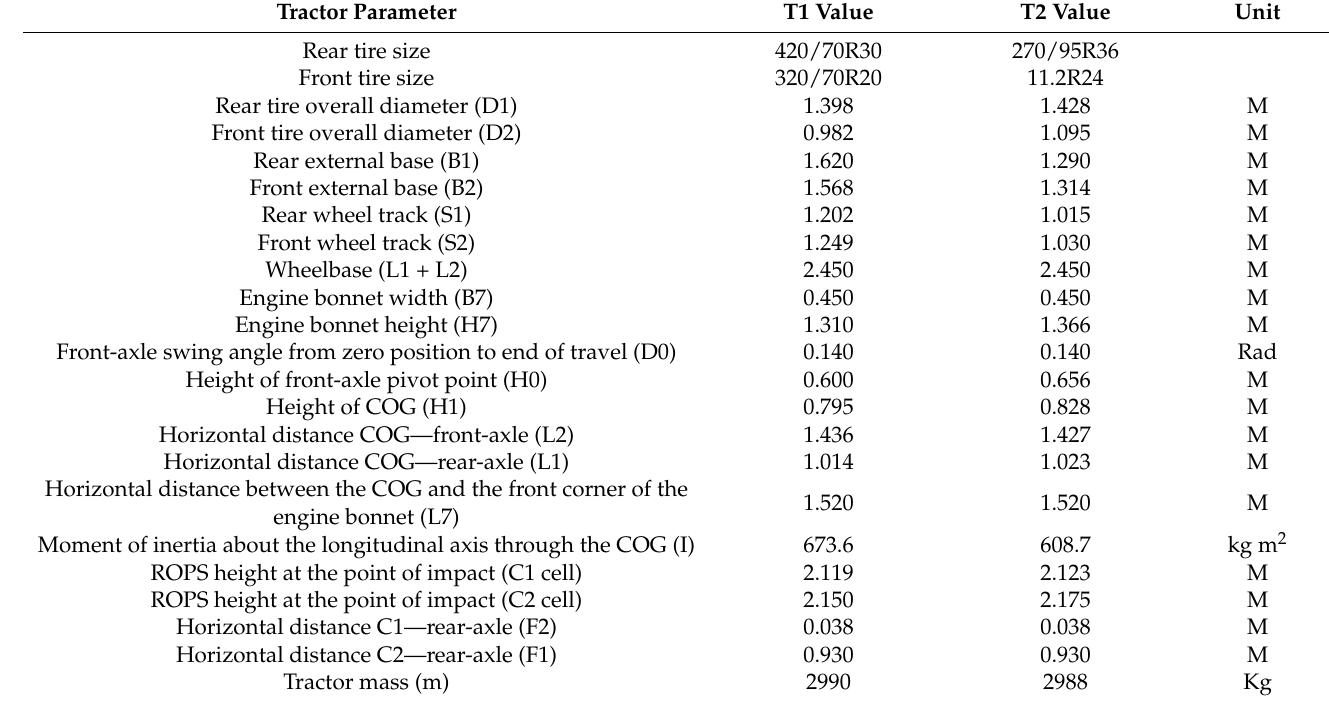
Table 1. Main physical parameters of the modified tested tractor in the T1 and T2 configurations. Tractor